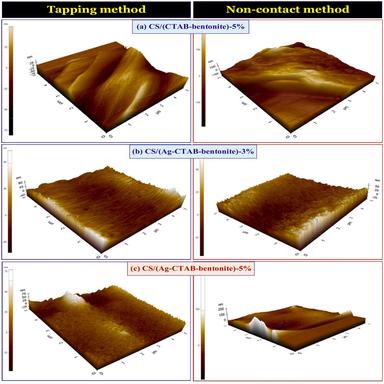
AFM images of the resultant films obtained by the tapping method and non-contact method.